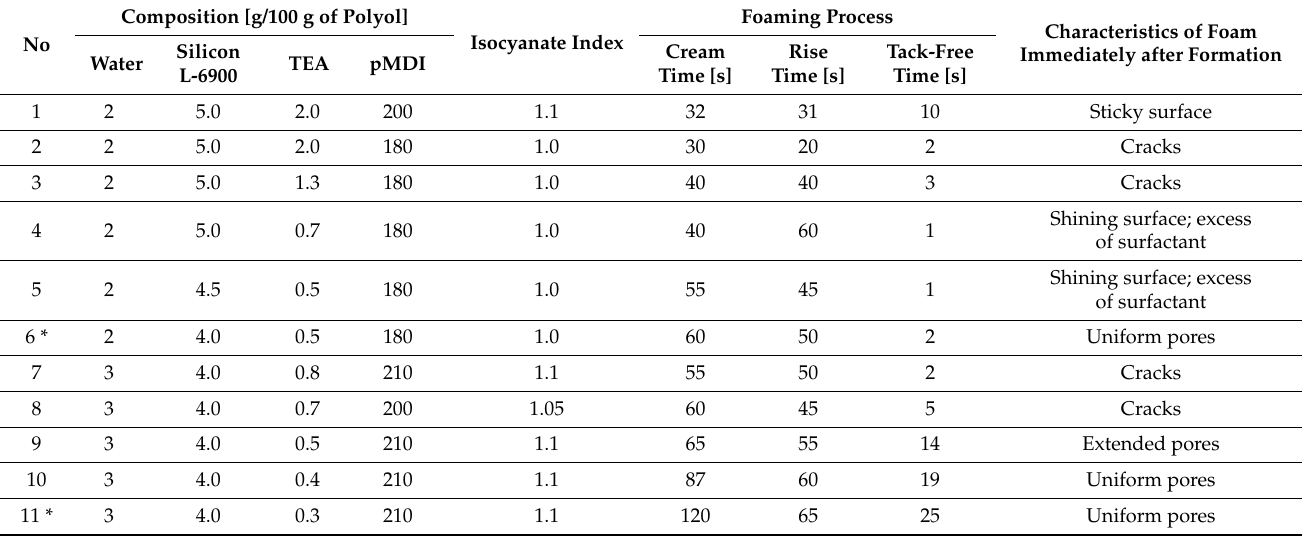
Table 5. The influence of composition on foaming